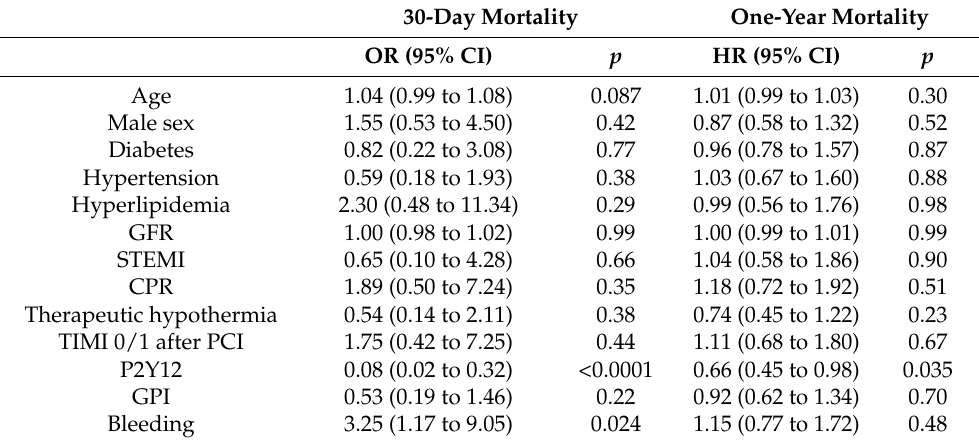
Table 2. Predictors of 30-day and one-year mortality.